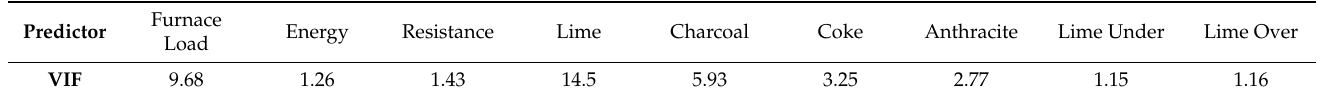
Table 2. Variance inflation factors of the calcium carbide furnace predictors.